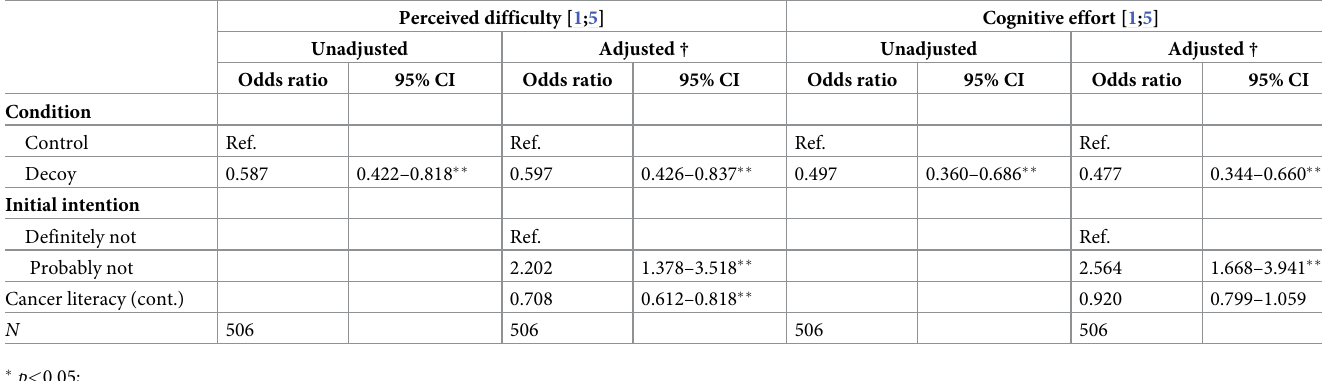
Table 2. Ordered logistic regression models on perceived difficulty and cognitive